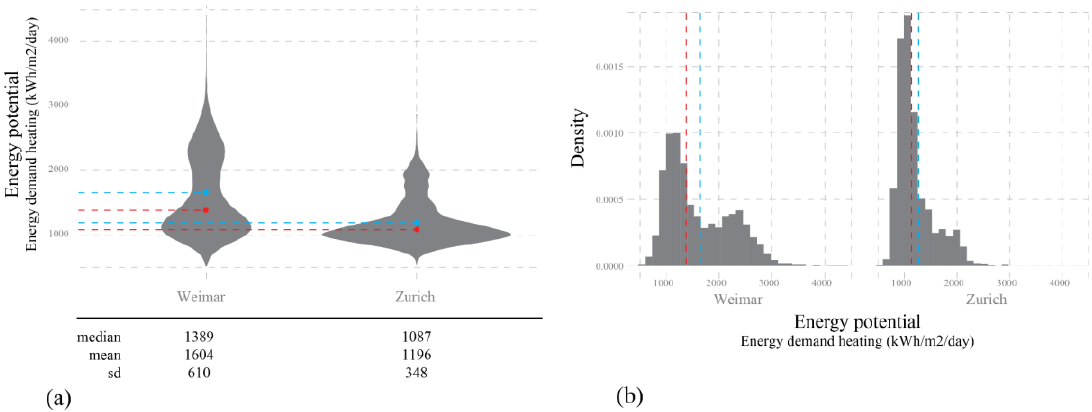
Figure 14. Distribution of the Energy potential (Building energy demand for heating in kWh/m 2 /day). ( a ) Violin plot, with highlighted median (red) and mean (blue) values; ( b ) histogram with highlighted median (red) and mean (blue).